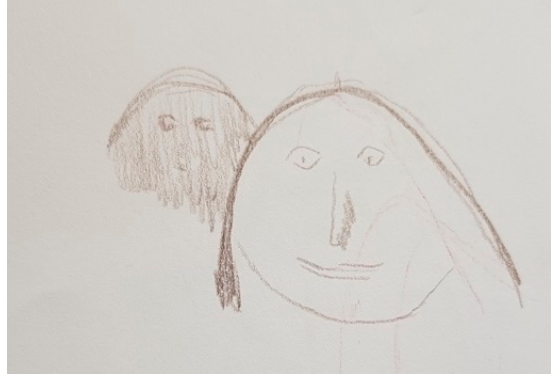
Figure 5. P35’s perception of PD.